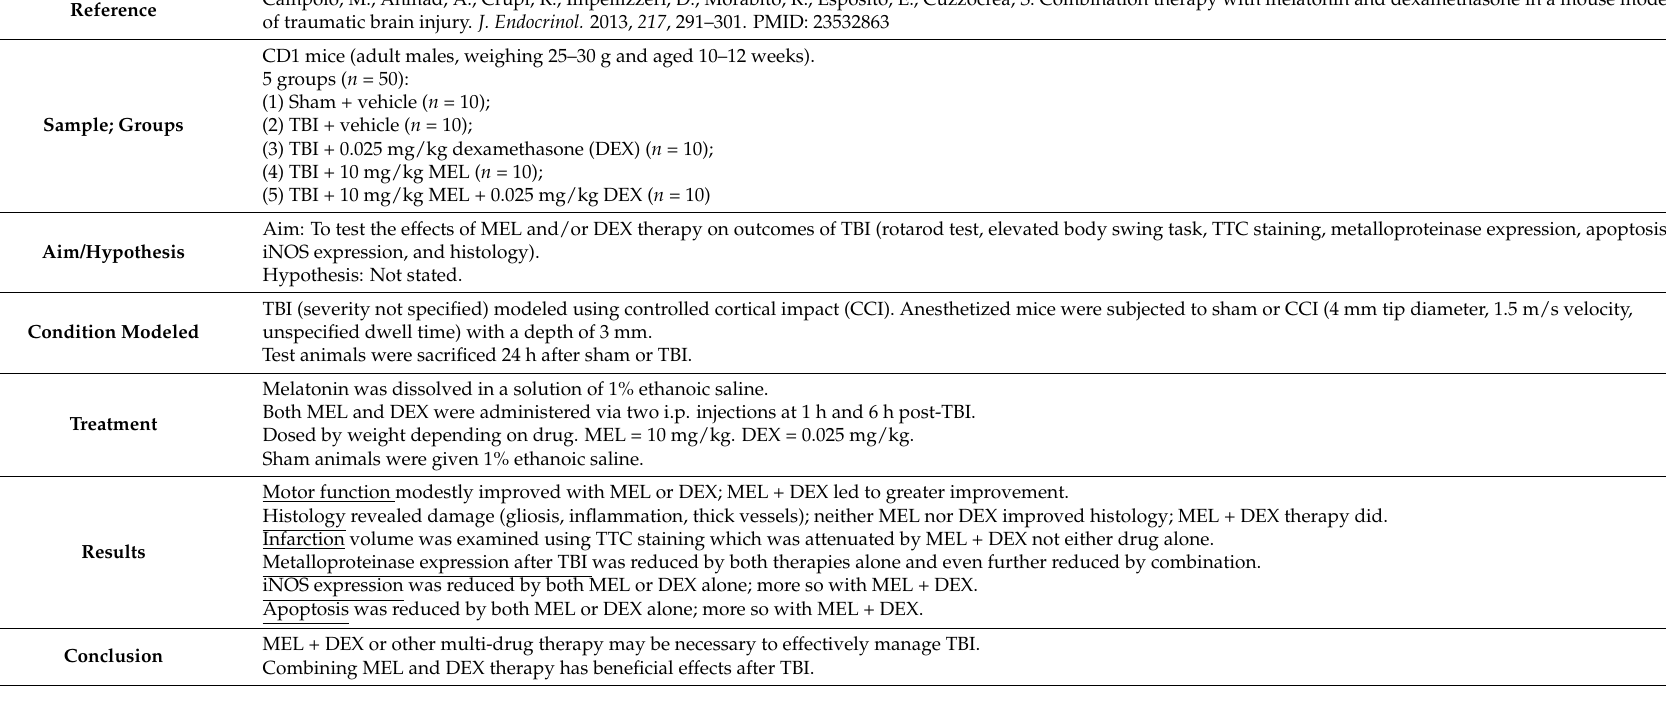
Table A13. Campolo et al. (2013) Study